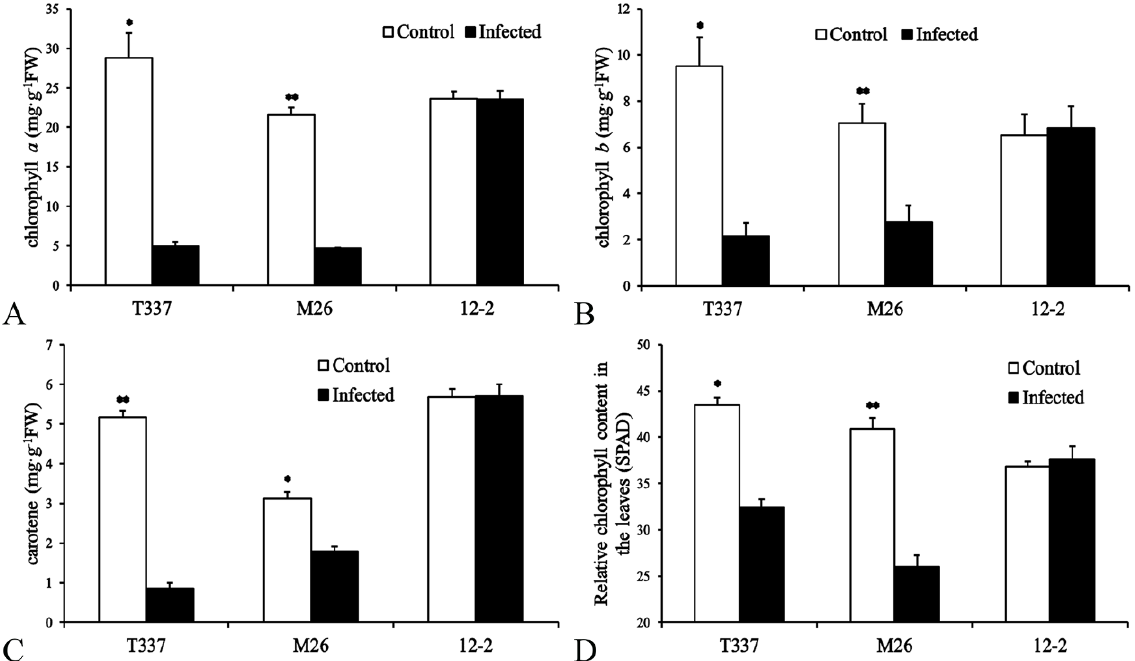
Figure 2. Effects of F. proliferatum MR5 on leaf chlorophyll contents: ( A ) chlorophyll a ; ( B ) chloro- phyll b ; ( C ) carotene; ( D ) SPAD. The Student’s t -test was used to detect the differences between the control and infected treatments within a rootstock. * p < 0.05; ** p <